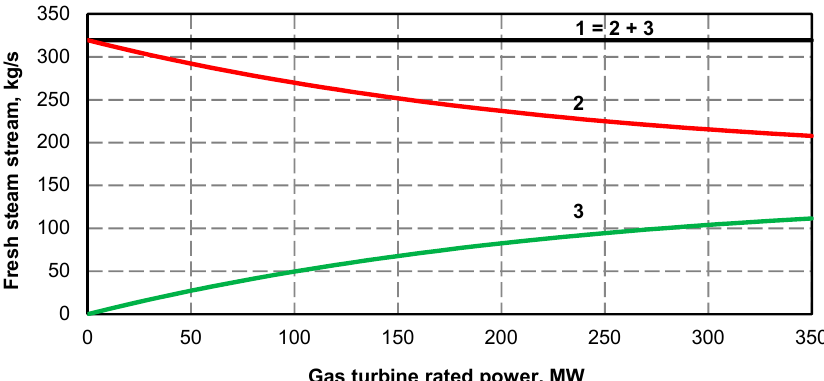
Figure 36. Fresh steam streams as a function of gas turbine rated power: 1 — maximum fixed steam stream of 319.4 kg/s fed to the steam turbine 2 — steam stream generated in the steam boiler, 3 — steam stream generated in the recovery boiler.